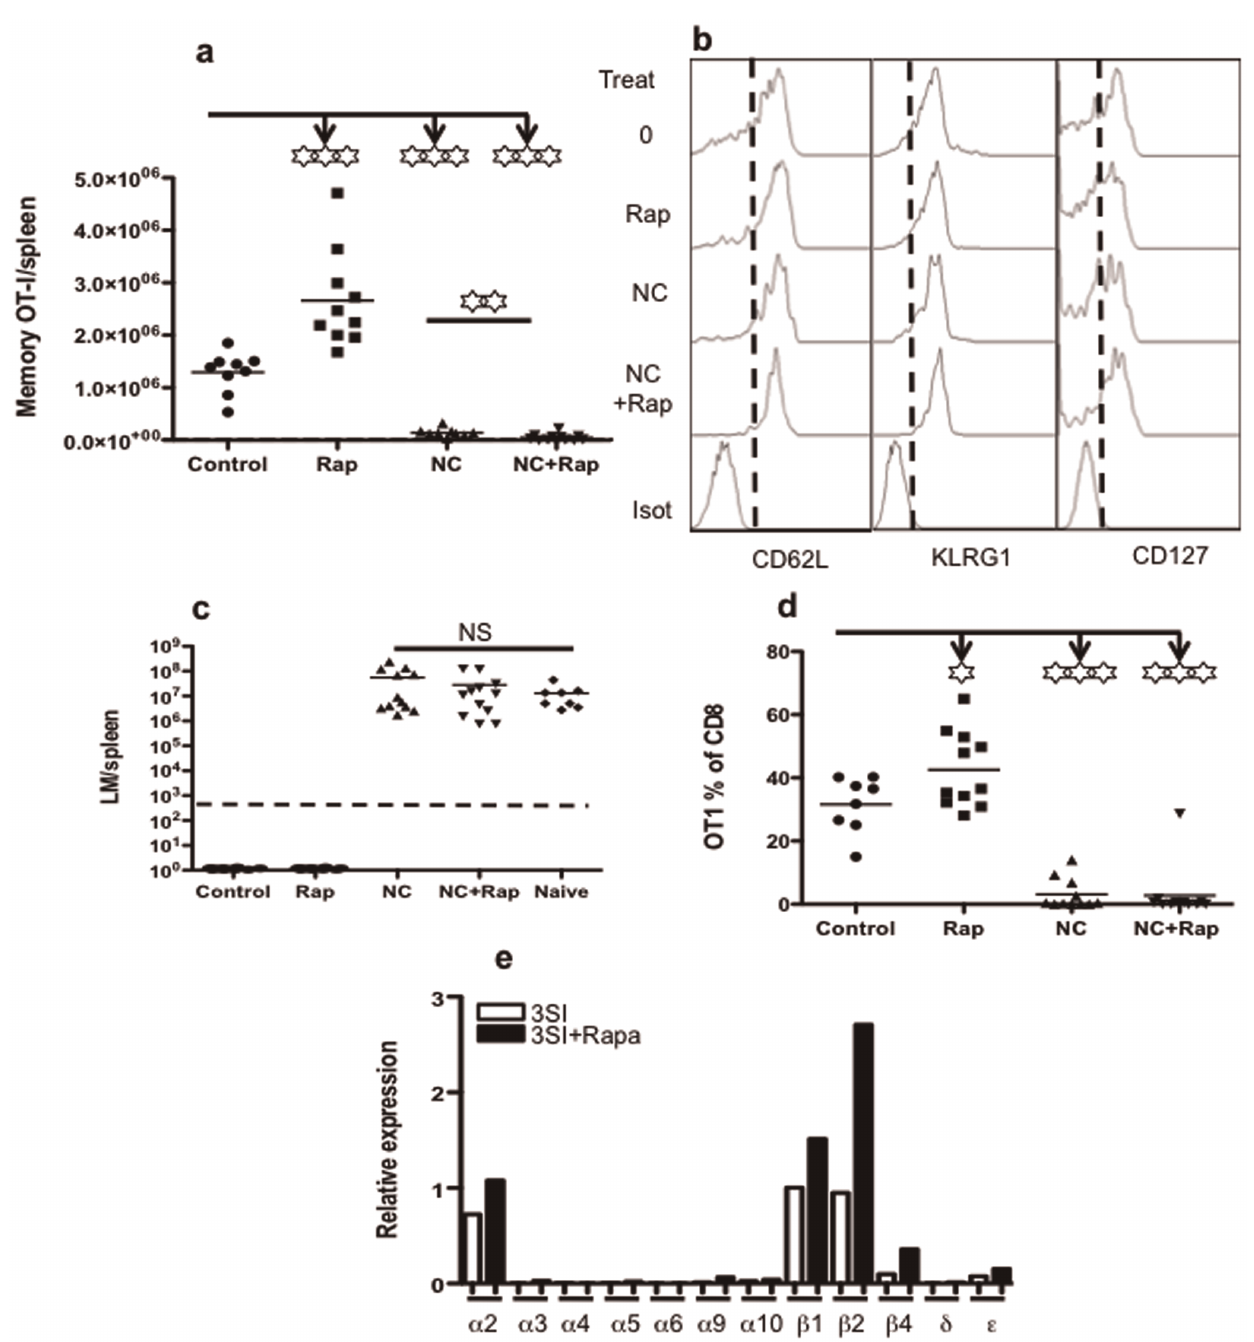
Figure 6. Nicotine abolishes the regulatory function of rapamycin on memory programming. Sorted OT-I cells were stimulated for 3 days with 3SI in the presence or absence of nicotine at 10 m M. Rapamycin was used in combination with or without nicotine. Cells were harvested and transferred into recipient B6 mice at a concentration of 10 6 cells/mouse. Memory CTLs were examined 40 days post-transfer. A. Comparison of memory CTLs in spleen. B. Comparison of the phenotype of memory CTLs in spleen. C. Comparison of memory protection against LM-OVA challenge in different memory mice in Panel A. D. Secondary expansion of memory CTLs 3 days post-LM-OVA challenge. These animals were the same as mentioned in Panel C. The results are representatives of two separate experiments with similar results. Asterisks indicate statistical significance. *, P , 0.05; **, P , 0.01; ***, P , 0.001. E. Sorted OT-I cells were stimulated for 3 days with 3SI in the presence or absence of rapamycin, and expression of nAChRs was compared relatively to b 1 in 3SI stimulation using quantitative PCR. Dotted lines in A and C indicate the detection limits. The results are representatives of two separate experiments with similar results. doi:10.1371/journal.pone.0068183.g006 expansion of CTLs after transfer (Fig.3A), which should contribute the protection ability of the nicotine-experienced memory CTLs at least partially to the reduced memory formation. Furthermore, was severely suppressed (by about 6 logs) (Fig. 4D), which is not